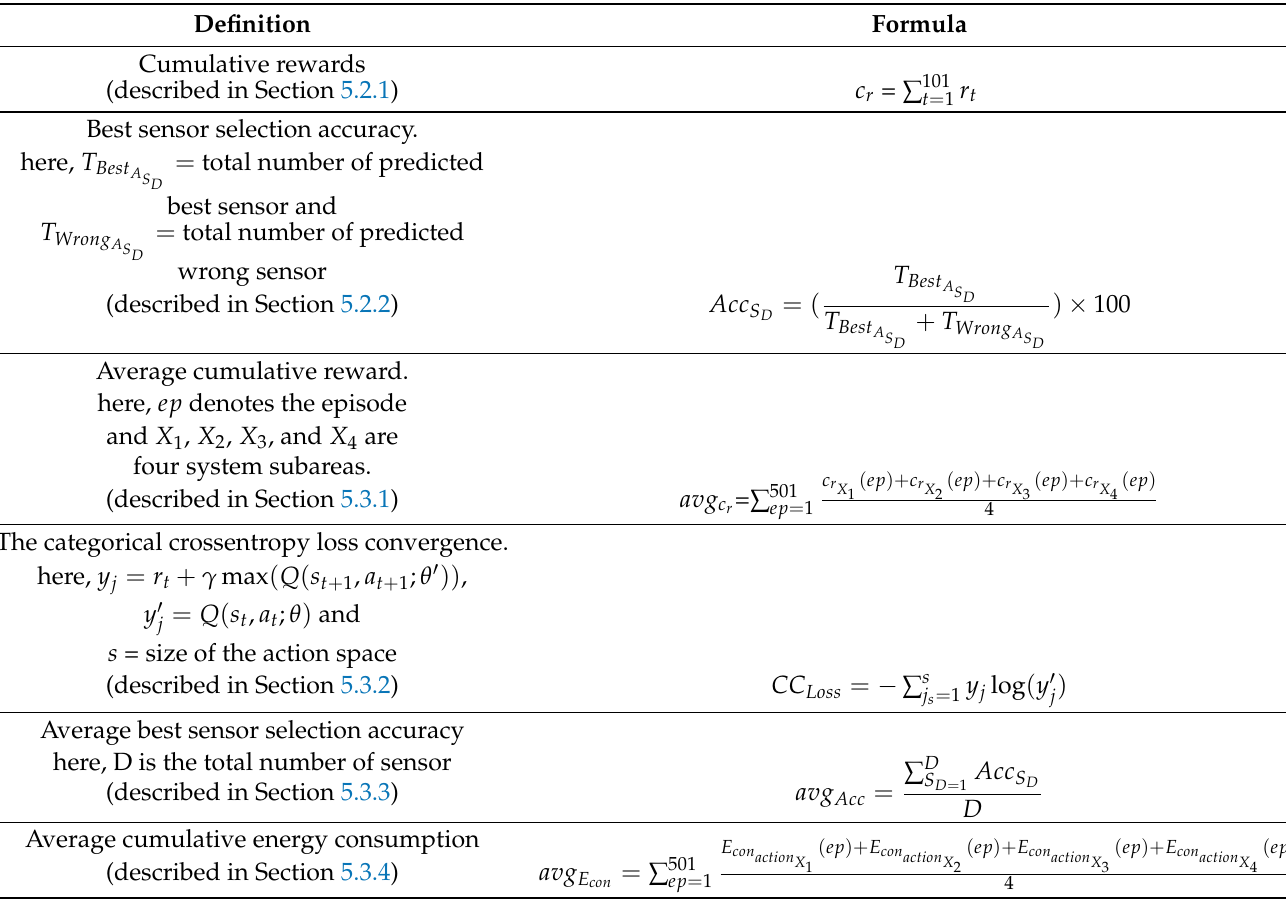
Table 5. A list of evaluation